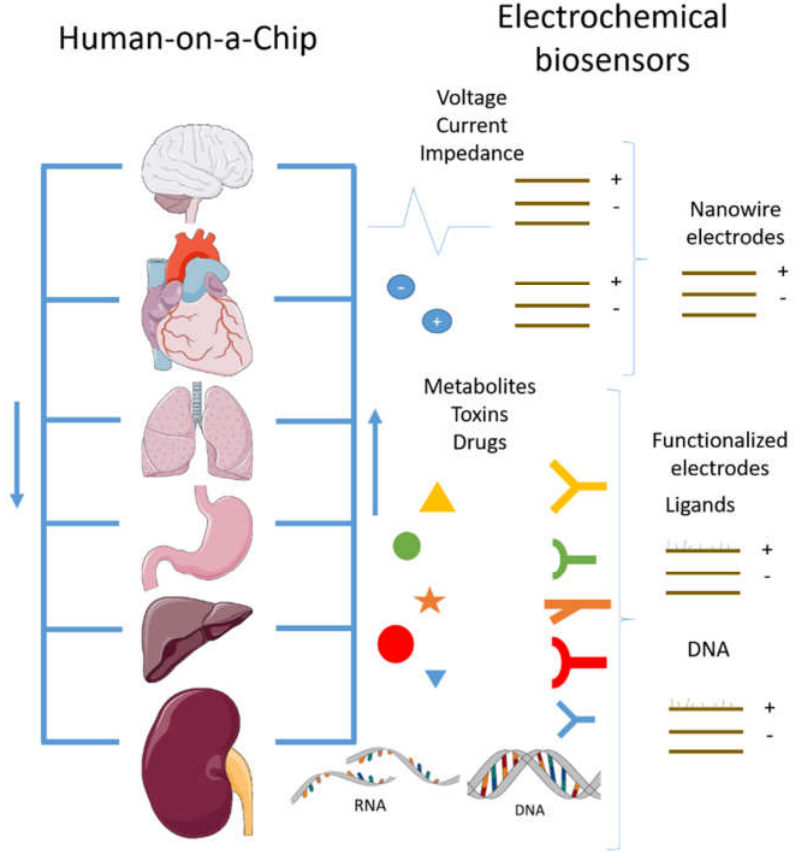
Figure 5. Organs-sensors-on-a-chip microfluidic representation.